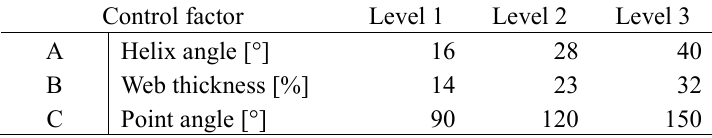
Table 1 Factors and levels considered in the experimental drills Control factor